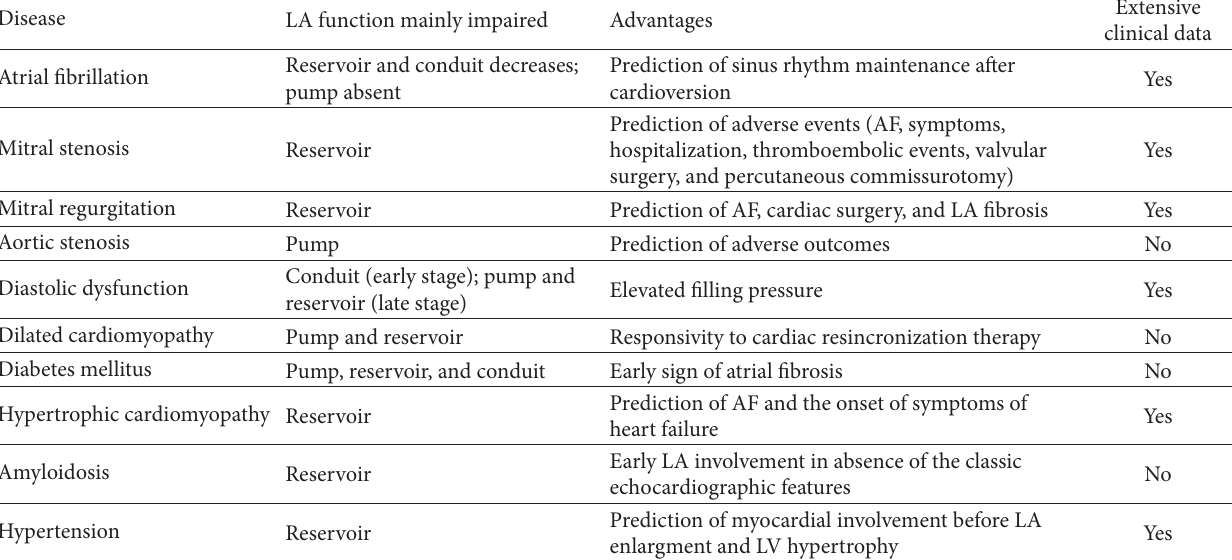
Disease Advantages